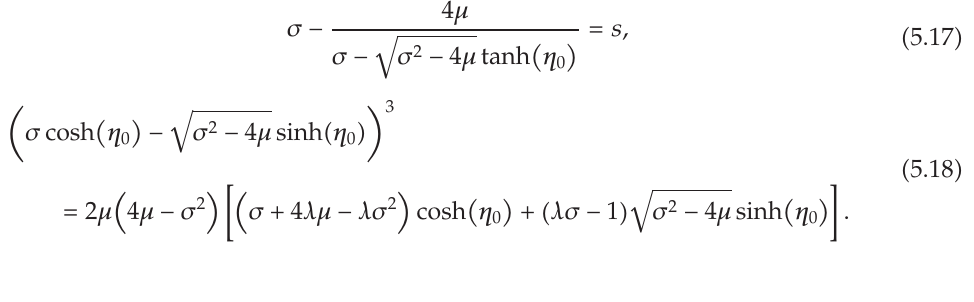
(cid:3) 2 (cid:4) When σ / (cid:8)